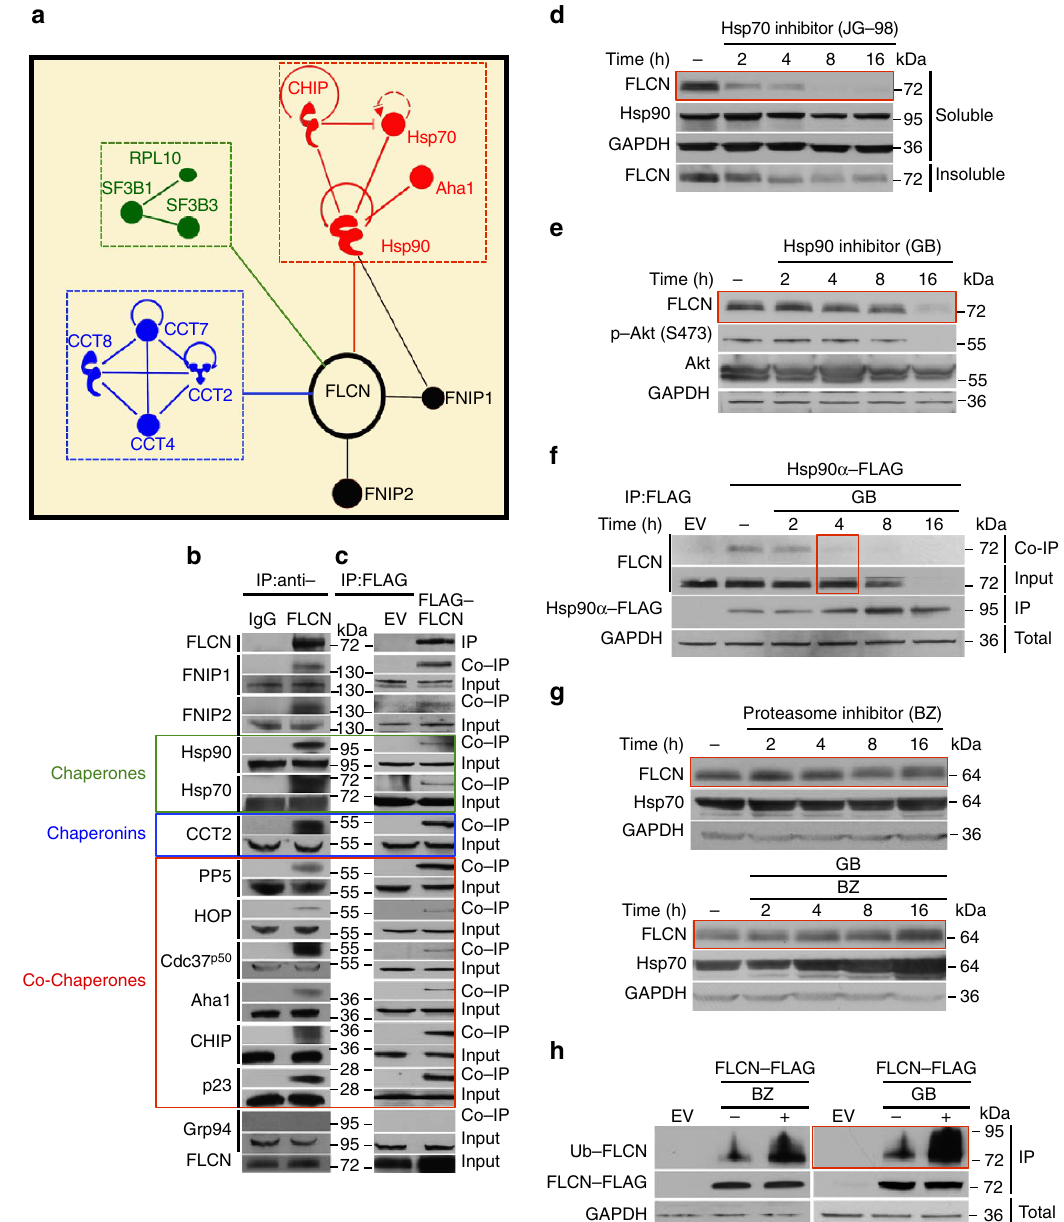
Figure 1 | Folliculin is a new client of Hsp90. ( a ) FLAG–FLCN was expressed and isolated from HEK293 cells. Profile of interacting proteins determined by MALDI–time of flight. Red nodes represent chaperones and co-chaperones, blue nodes are chaperonins and green nodes are splicing factors and ribosomal proteins. ( b ) FLCN was isolated from HEK293 cell lysates using anti-FLCN or IgG (control) and immunoblotted with indicated antibodies to confirm protein interactions. ( c ) HEK293 cells were transiently transfected with FLAG–FLCN or empty vector control (EV), immunoprecipitated and immunoblotted with indicated antibodies to confirm interacting proteins. ( d ) HEK293 cells were treated with 10 m M of the Hsp70 inhibitor JG-98 at the indicated time points. FLCN protein stability in soluble and insoluble fraction was assessed by immunoblotting. ( e ) HEK293 cells were treated with 1 m M GB at the indicated time points. FLCN protein stability was assessed by immunoblotting. Akt and Phospho-S473-Akt were used as positive controls. ( f ) Hsp90 a –FLAG was transiently expressed in HEK293 cells. Cells were treated with 1 m M GB for the indicated times. Hsp90 a –FLAG was immunoprecipitated and co-IP of